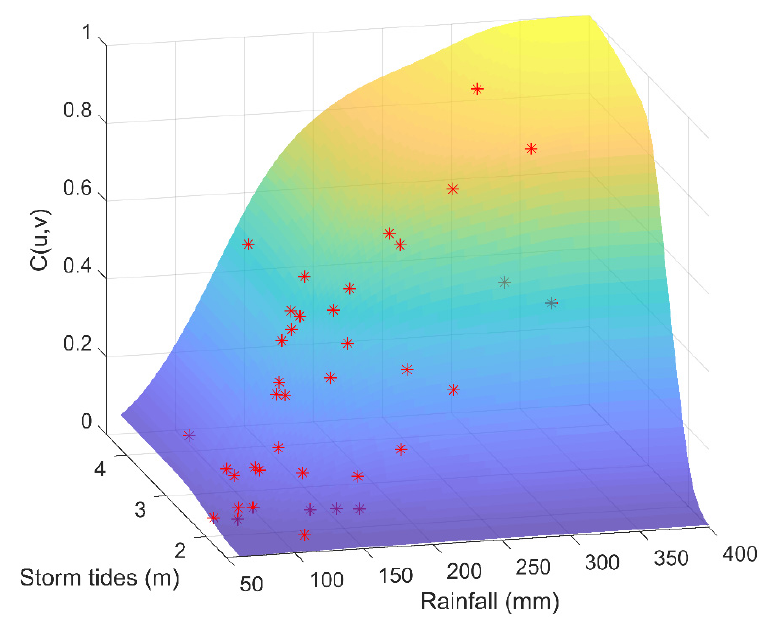
Figure 9. C ( u , v ) of rainfall and storm tides (non-parametric estimation method). Red dots are observed values.